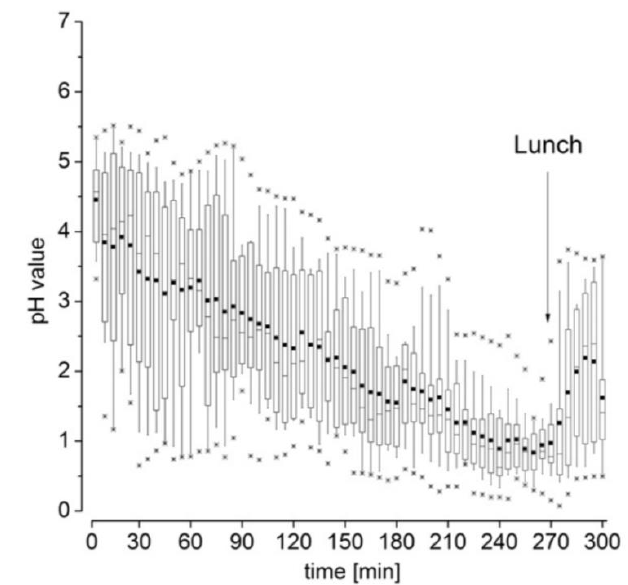
Figure 3. Gastric pH values after administration of the SmartPill ® in fed state. Reprinted from Reference [23] with permission from Elsevier.